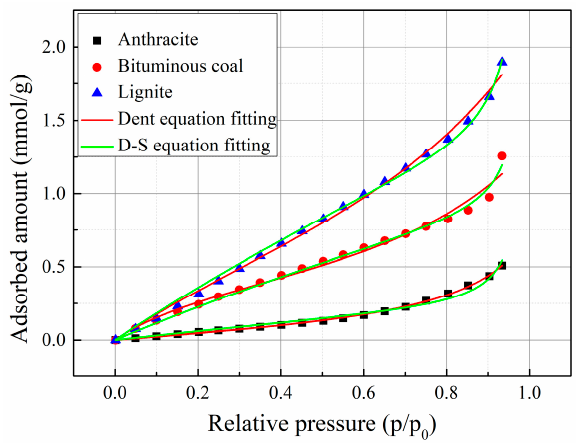
Figure 9. Fitting models to the experimental data. Table 3. Fitting parameters by the models.